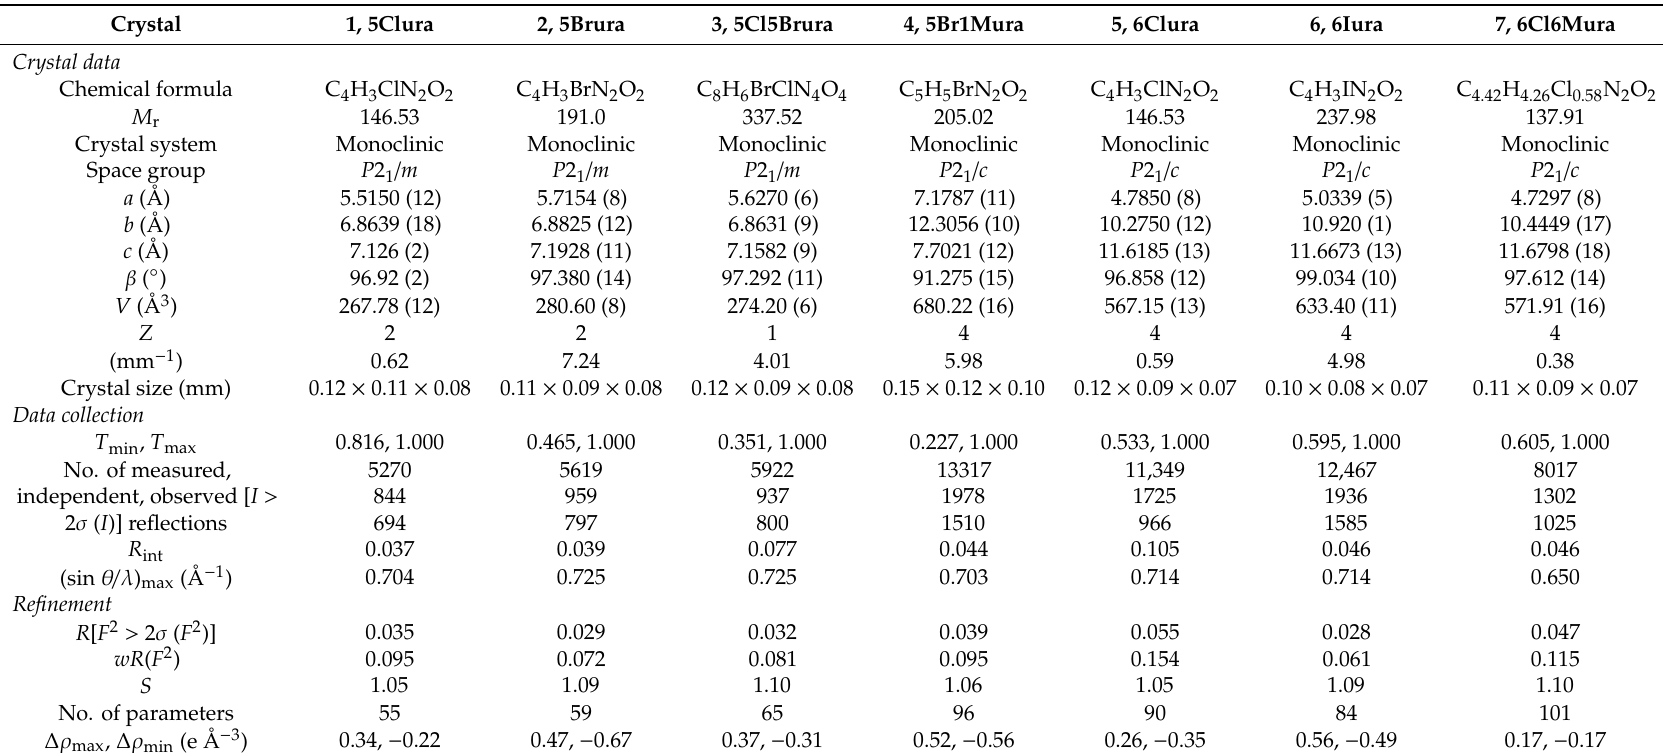
Table 1. Crystal data, data collection, and refinement for compounds